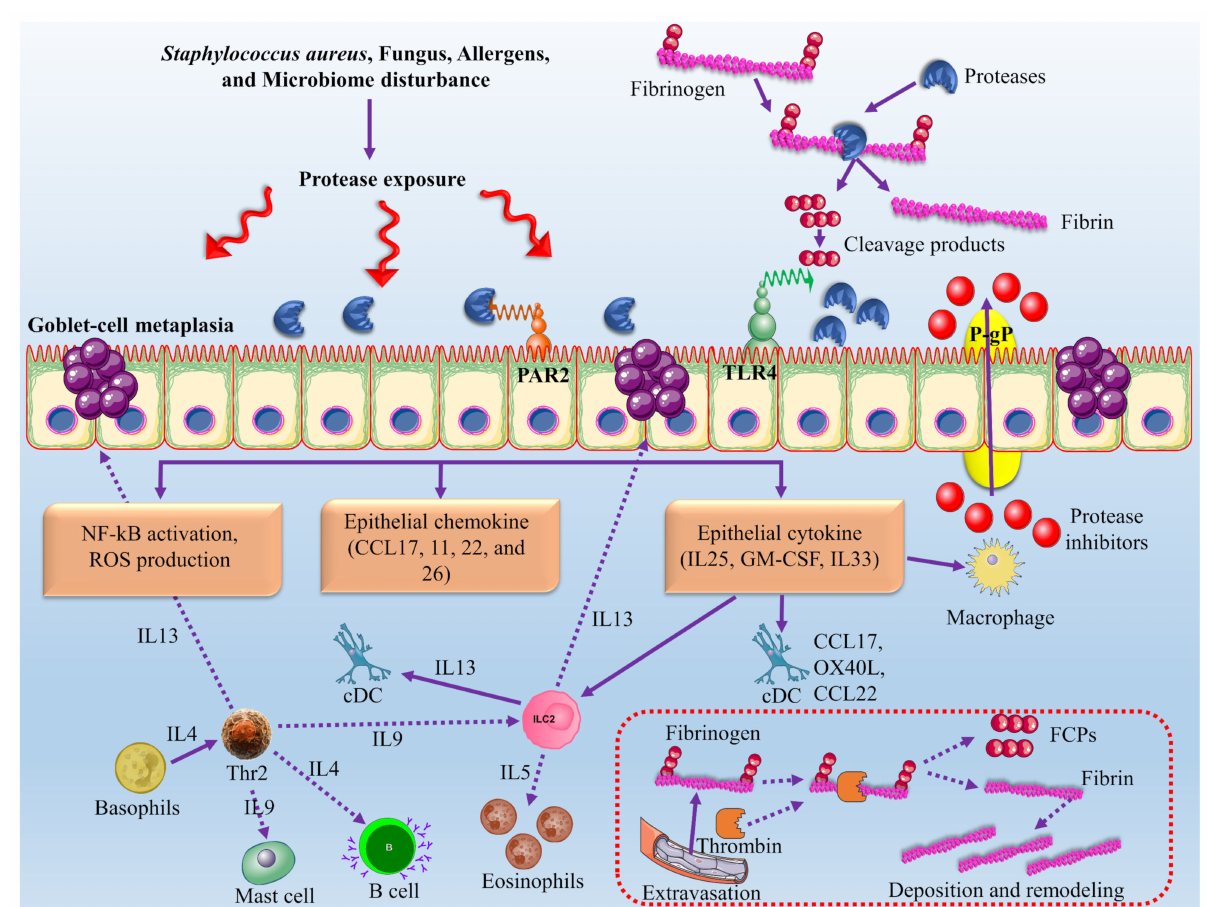
Figure 6. The mechanism of action of proteases to inhibit the allergen and other microbe attacks. Proteases are released in response to allergens due to a microbial attack that causes severe damage to epithelial cells by disrupting the junctional proteins [192]. Allergen proteases bind to protease- activated receptor 2 (PAR2) by cleaving the fibrinogen into the fibrin cleavage products (FCPs) that activate the toll-like receptor 4 (TLR4) and ILC2s. These ILC2s lead to activation of NF-kB and excess production of reactive oxygen species (ROS). It activates epithelial cells to release the pro-Th2 cell chemokines and cytokines that activated the instruct immature dendritic cells (iDCs). P-glycoproteins (P-gp) helps in removing the protease inhibitors in epithelial cells that cause the suppression of allergen proteases [190,193]. This figure is reproduced from Wu et al. [190] (Attribution 4.0 International, CC BY